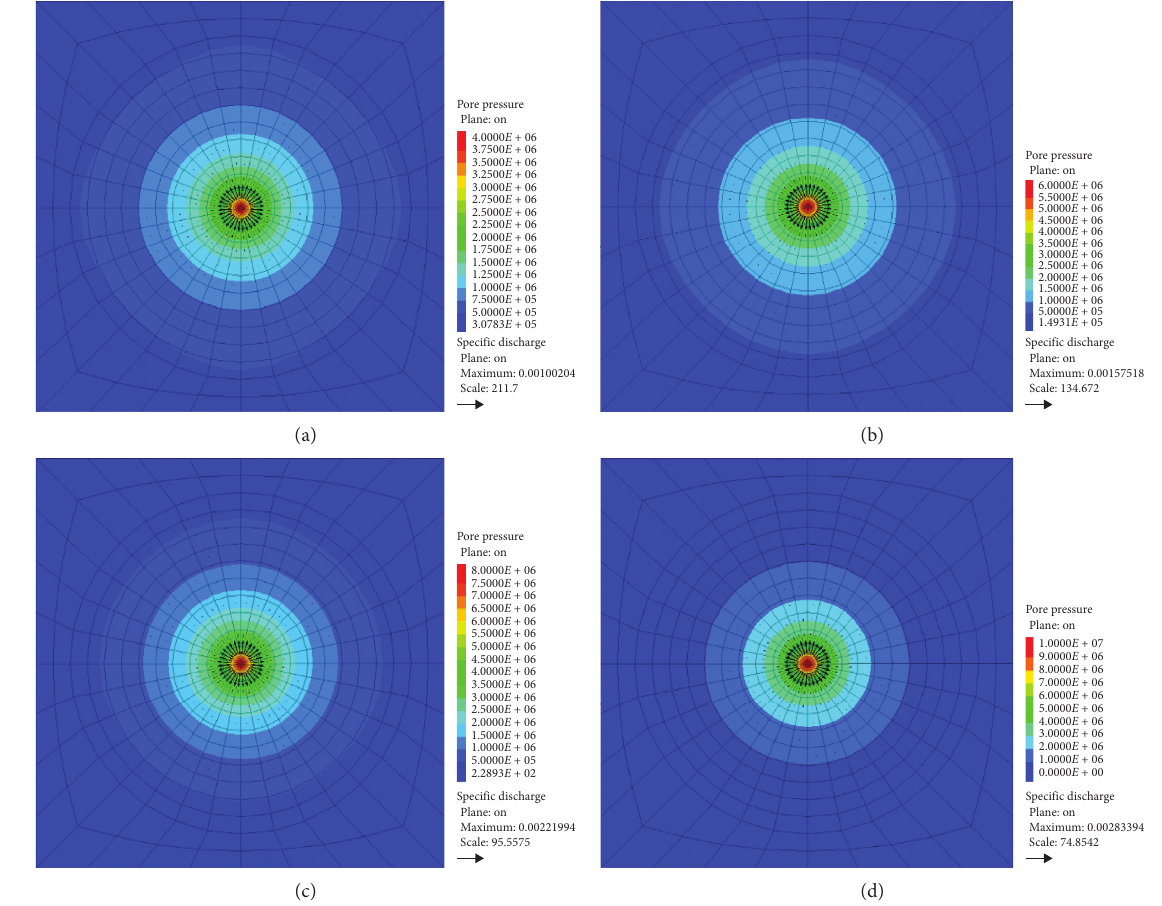
Figure 8: Distribution characteristics of radial pore pressure. (a) 4MPa. (b) 6MPa. (c) 8MPa. (d) 10MPa.